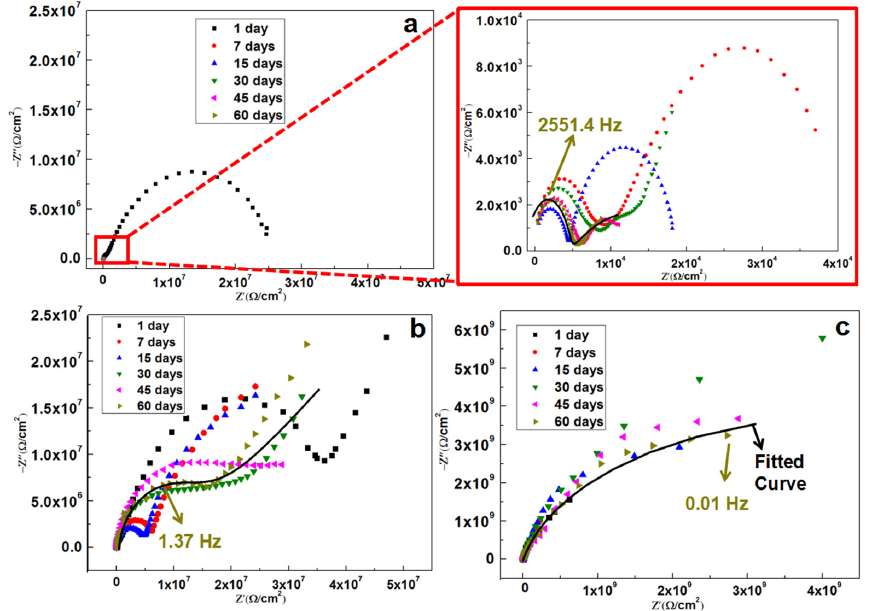
Figure 4. Nyquist plots of ( a ) pure epoxy coating, ( b ) OTiO 2 (w) epoxy coating, ( c ) and iETiO 2 (w) epoxy coating.